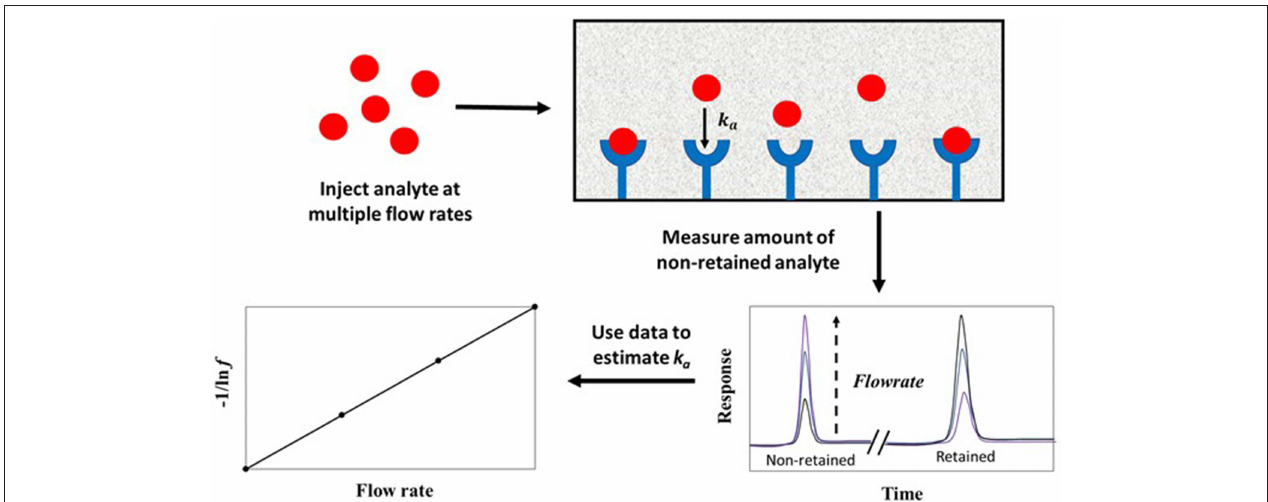
FIGURE 8 | General scheme used for studying analyte interactions with an immobilized binding agent by the split-peak method. Terms: k a , association rate constant; f , free fraction of the analyte which is non-retained by the